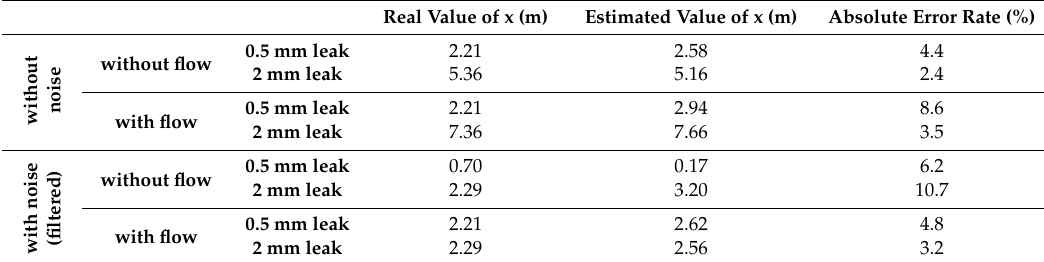
Table 4. Results from the BCC method for 8.5 m distance between the sensors.